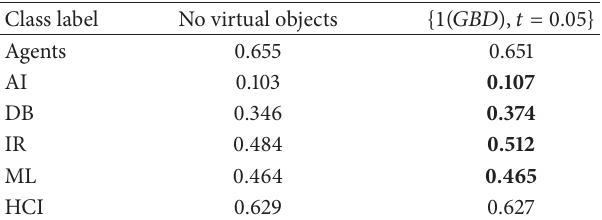
Table 9: Comparison of classification ability of each class, CiteSeer.